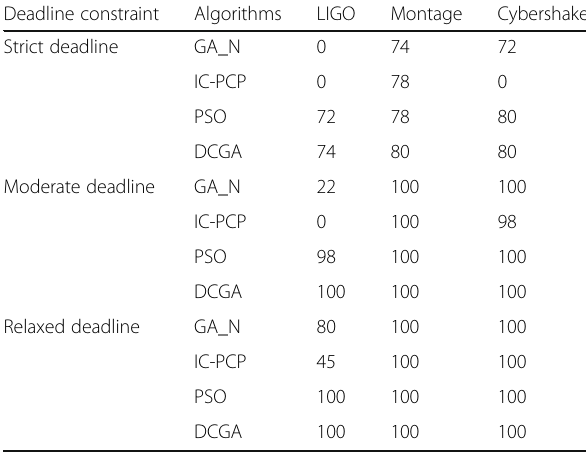
Table 4 Total success rates for